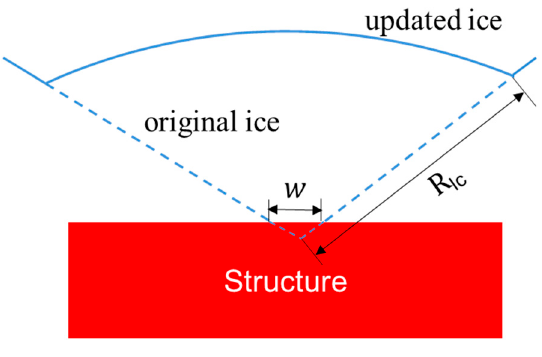
Figure 6. Ice crushing failure and updated ice.